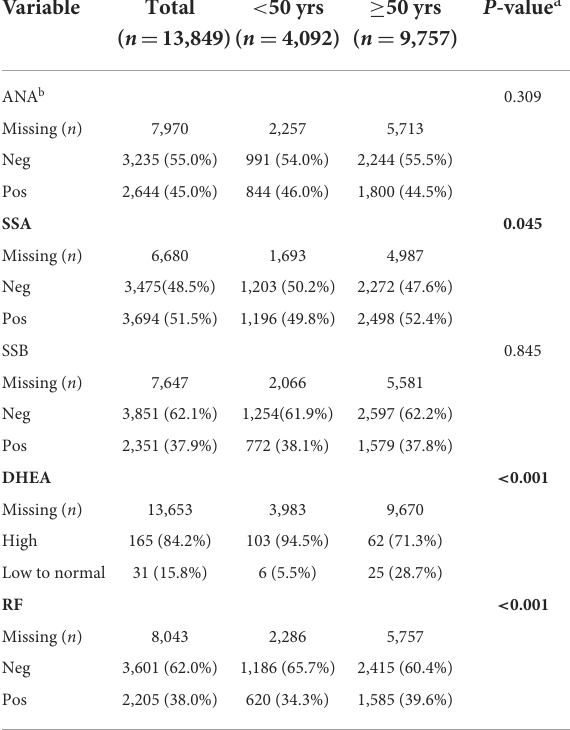
TABLE 4 Autoantibodies and DHEA in Sjögren’s disease patients by age. Variable